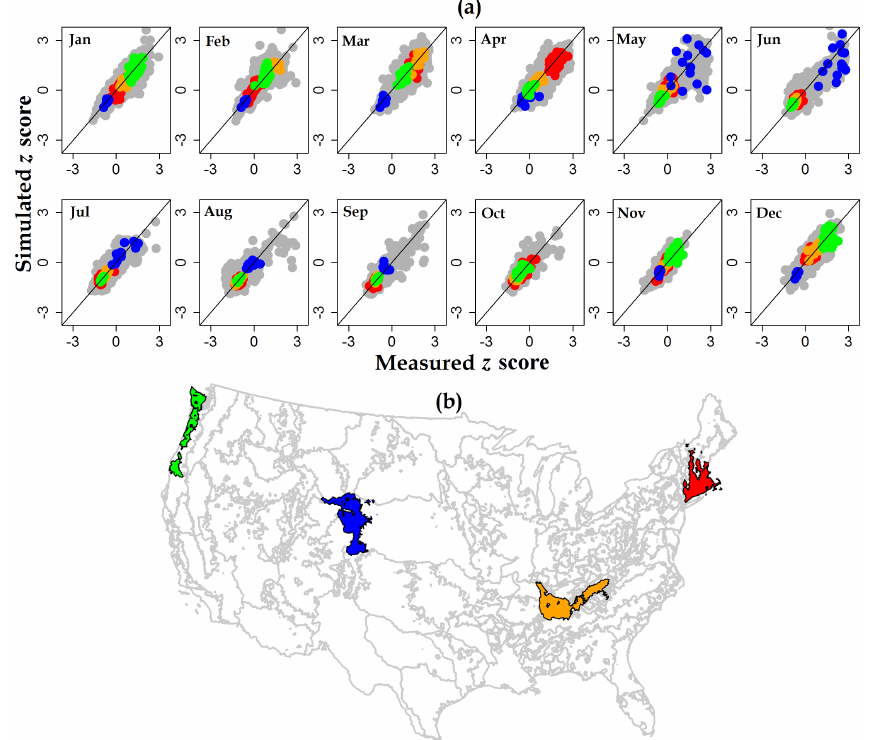
Figure 10. (a) Measured vs. simulated mean monthly z scores for runoff at all streamgages and (b) location of highlighted streamgages for four calibration regions: New England (67 streamgages, red); Tennessee River (21 streamgages, orange); Platte Headwaters (15 streamgages, blue); and Pacific Northwest (33 streamgages, green).